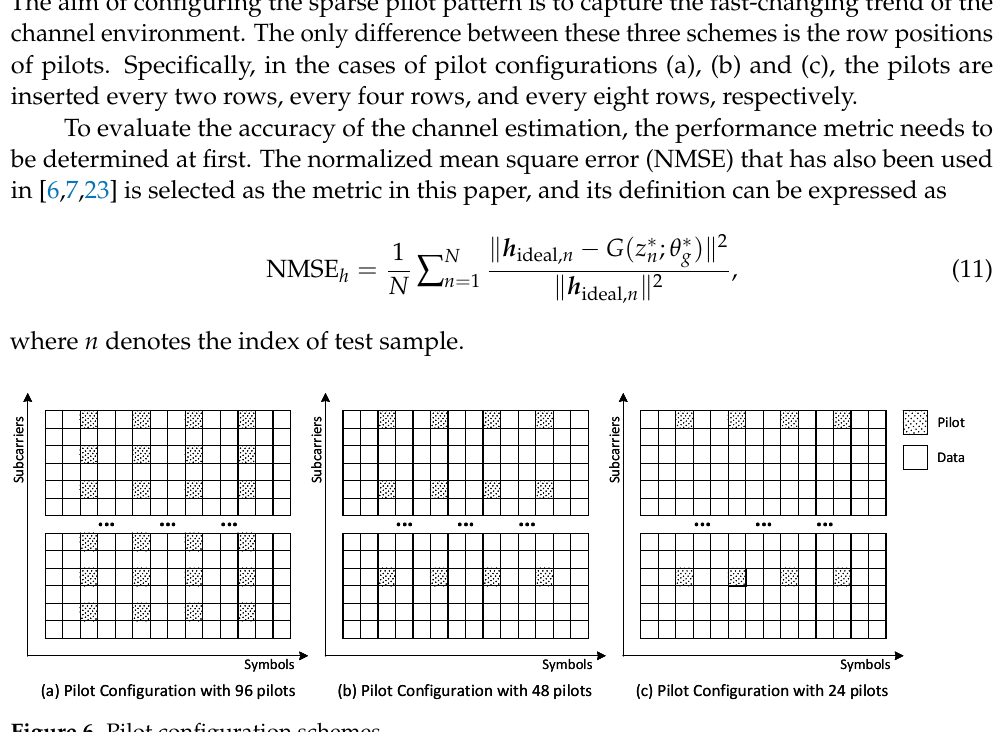
Figure 6. Pilot configuration